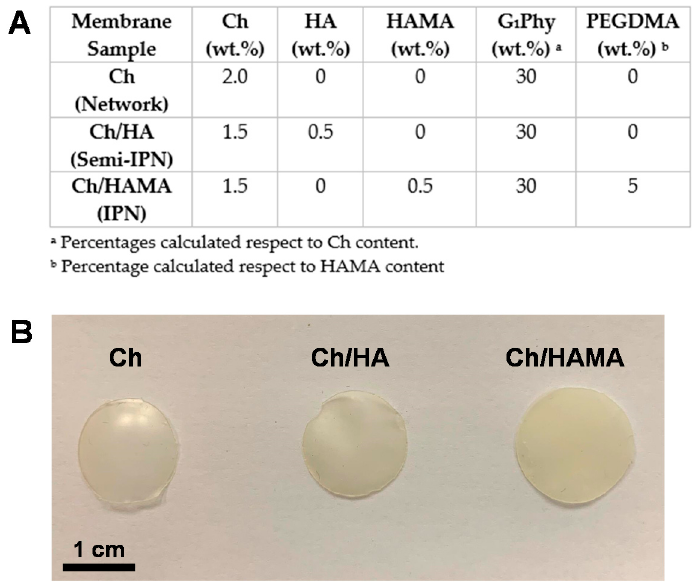
Figure 1. Polymer and crosslinker concentrations (wt.%) used for the fabrication of Ch membranes, semi-, and IPNs developed in this work ( A ); Digital images of the developed systems ( B ).